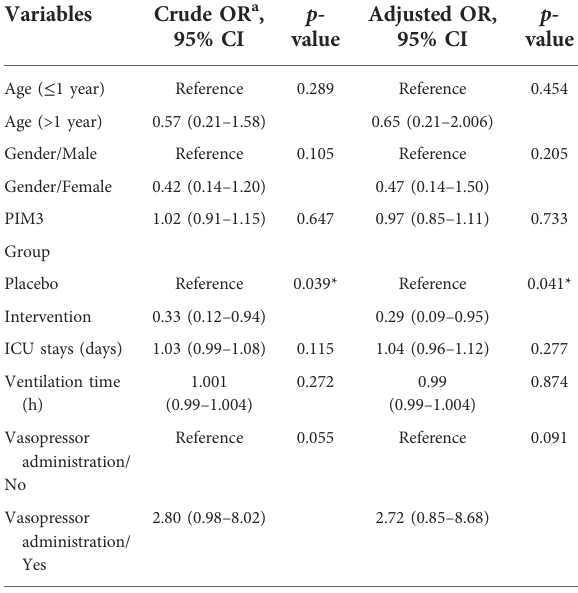
TABLE 5 Factors associated with VAP based on univariate and multivariable logistic regression model.